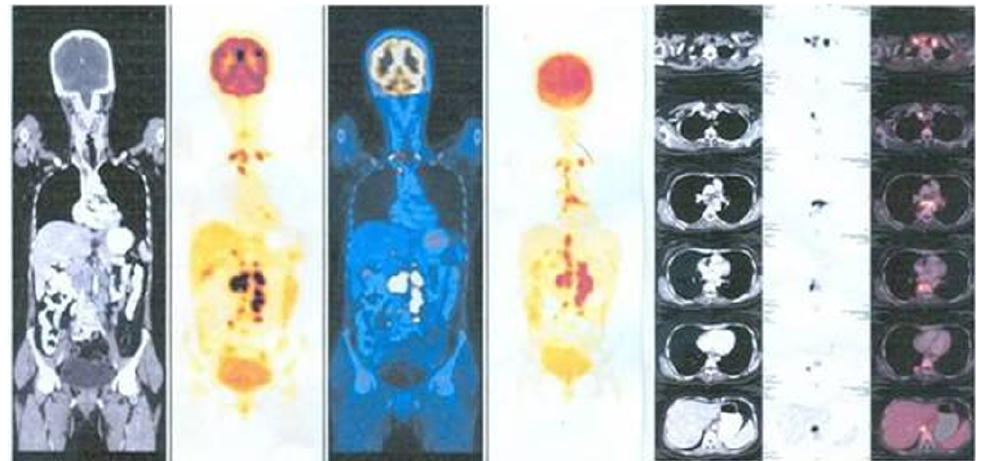
Figure 4: PET scan shows enlarged lymph nodes in cervical, mediastinal, and retroperitoneal regions.